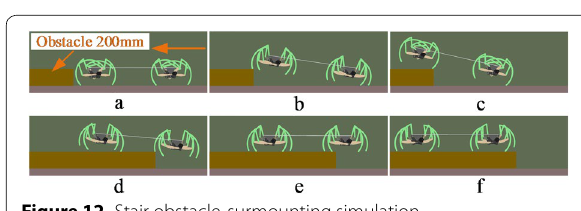
Figure 12 Stair obstacle-surmounting simulation